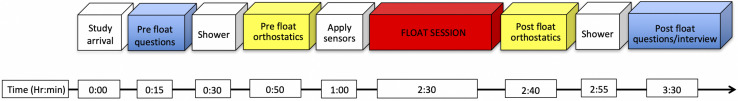
Approximate timeline of assessments during each REST session. Sensor application included the application of a wireless blood pressure monitor and waterproof cast. The total duration of each session was approximately 3.5 h.